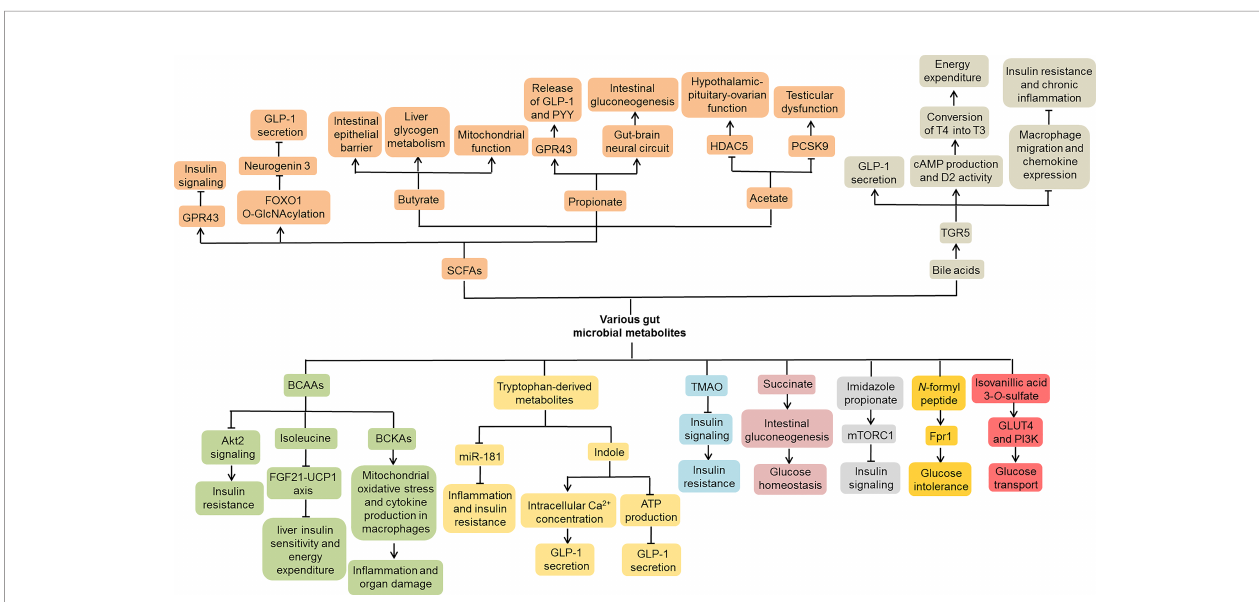
FIGURE 4 | Molecular mechanisms of gut microbial metabolites involved in T2DM. Various gut microbial metabolites, including SCFAs, bile acids, BCAAs, tryptophan-derived metabolites, TMAO, succinate, imidazole propionate, N -formyl peptide and isovanillic acid 3- O -sulfate, contribute to the development of T2DM through complex molecular mechanisms. SCFAs, Short chain fatty acids; BCAAs, Branched-chain amino acids; TMAO, Trimethylamine N-oxide; GPR43, G protein- coupled receptor 43; FOXO1, Forkhead box O1; GLP-1, Glucagon-like peptide-1; PYY, Peptide YY; HDAC5, Histone deacetylase-5; PCSK9, Proprotein convertase subtilisin/kexin type 9; TGR5, Takeda G-protein receptor 5; cAMP, Cyclic AMP; D2, Type 2 iodothyronine deiodinase; FGF21, Fibroblast growth factor 21; UCP1, Uncoupling protein 1; BCKAs, Branched-chain a -keto acids; mTORC1, Mechanistic target of rapamycin complex 1; GLUT4, Glucose transporter 4; PI3K, Phosphoinositide